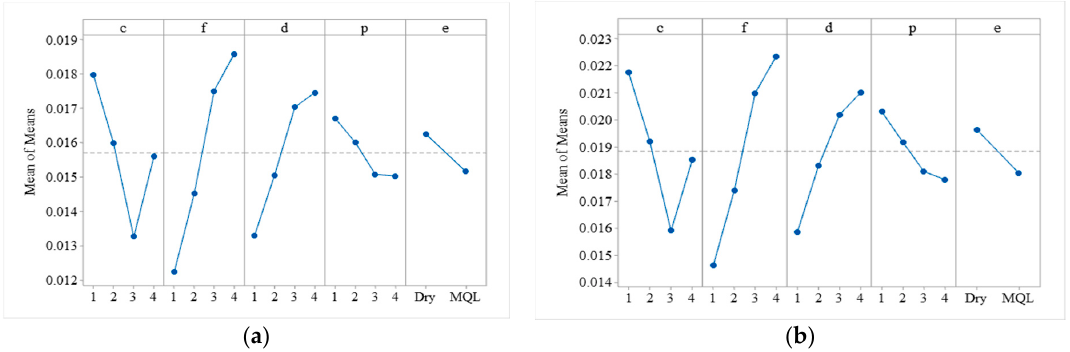
Figure 8. Main effect plot for means of shape deviations. ( a ) circularity ( b ) cylindricity. Figure 8. Main e ff ect plot for means of shape deviations. ( a ) circularity ( b )